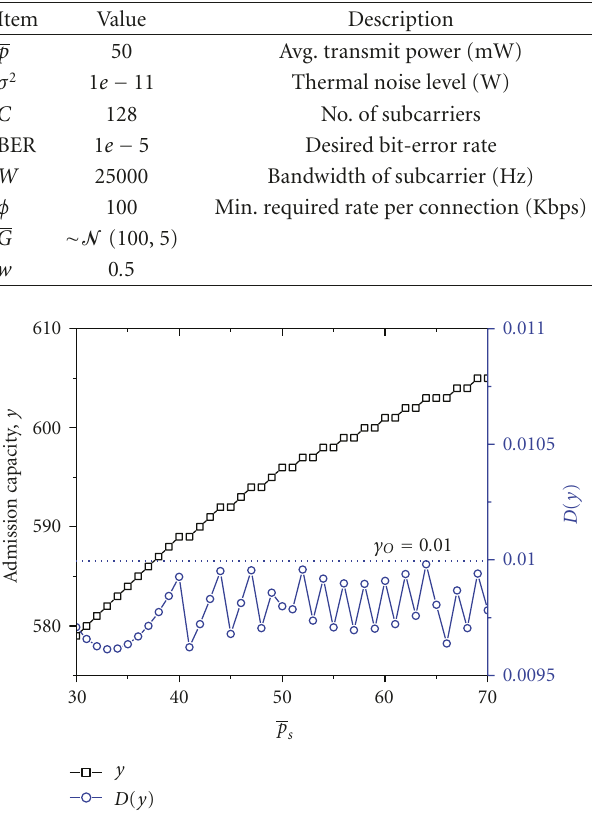
Figure 3: Relation between the admission capacity and the transmit power of the source node when transmitting its own tra ffi c γ O = 0 .